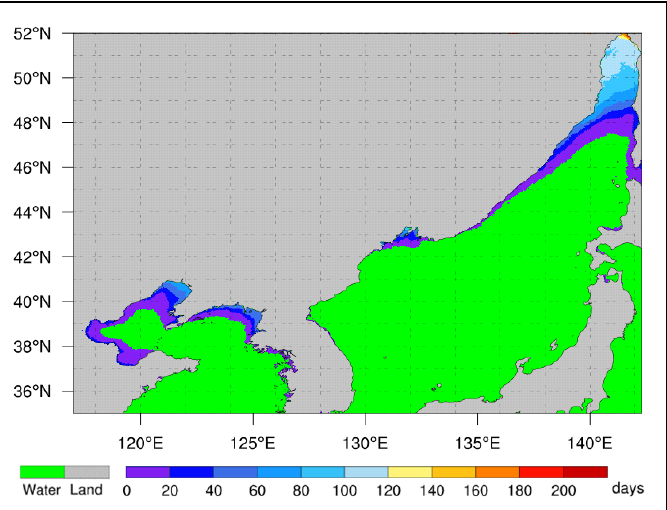
Figure 2. Annual average duration of sea ice cover in the marginal seas of East Asia from 2005 to 2021.